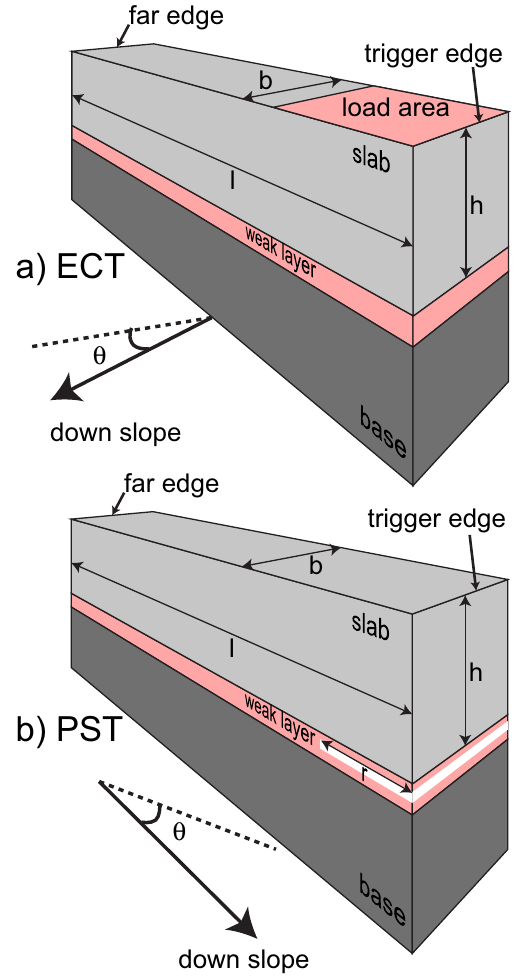
Figure 2. ECT and PST geometry. Shown are the slab width b , slab height h , length l , slope angle θ , crack length r , and the far/trigger edges of the